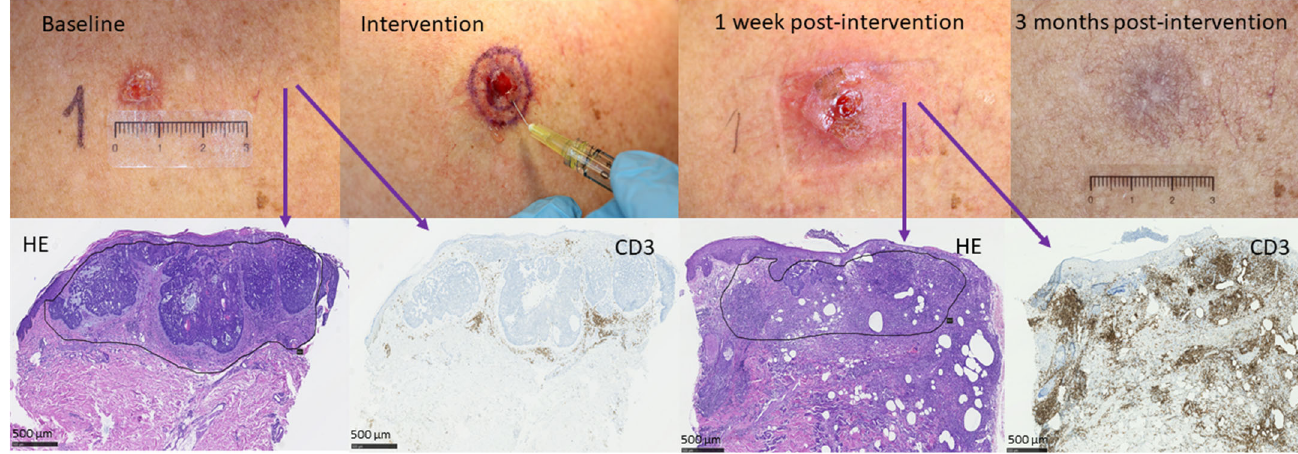
Figure 3. Tumor response to anti ‐ PD1 and adjuvant AFL. Clinical and histological photos of one of the tumors treated with anti ‐ PD1 with adjuvant AFL obtaining CR. The histological photos stained with hematoxylin and eosin (HE) and CD3 at baseline and one week following intervention clearly show a marked increase in peritumoral inflammation, with very subtle inflammation prior to treatment and a dense inflammatory infiltrate one week after combination therapy. Scale bar: 500 μ m.